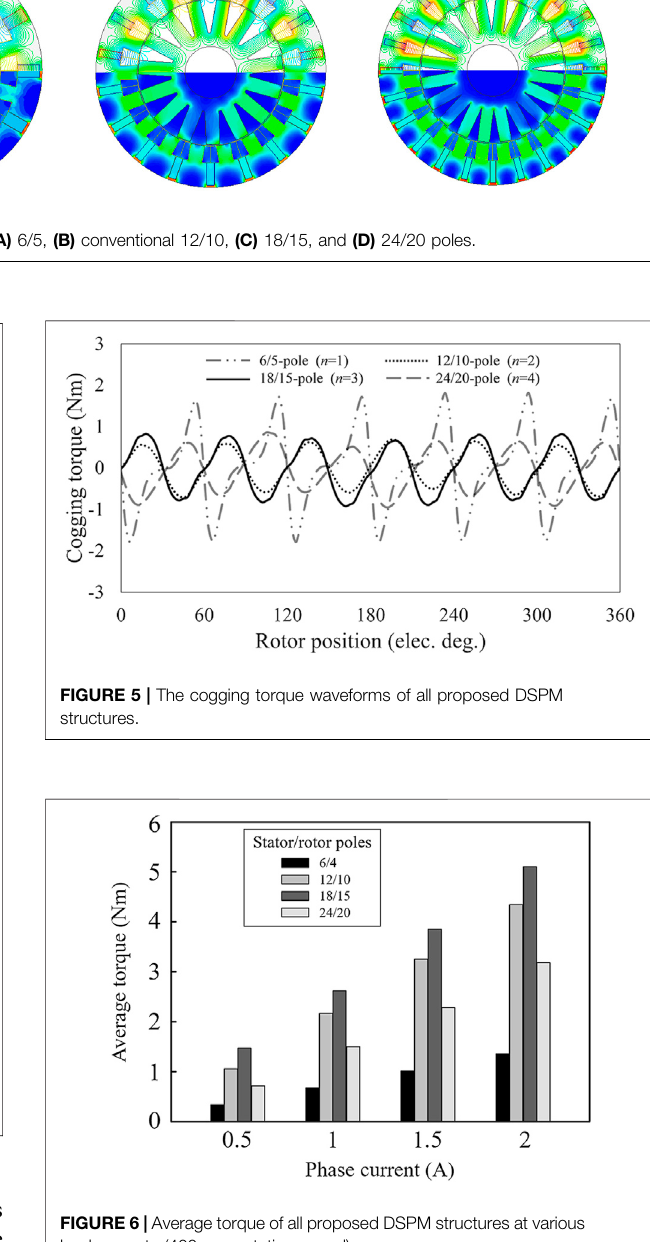
FIGURE 6 | Average torque of all proposed DSPM structures at various load currents (400 rpm rotating